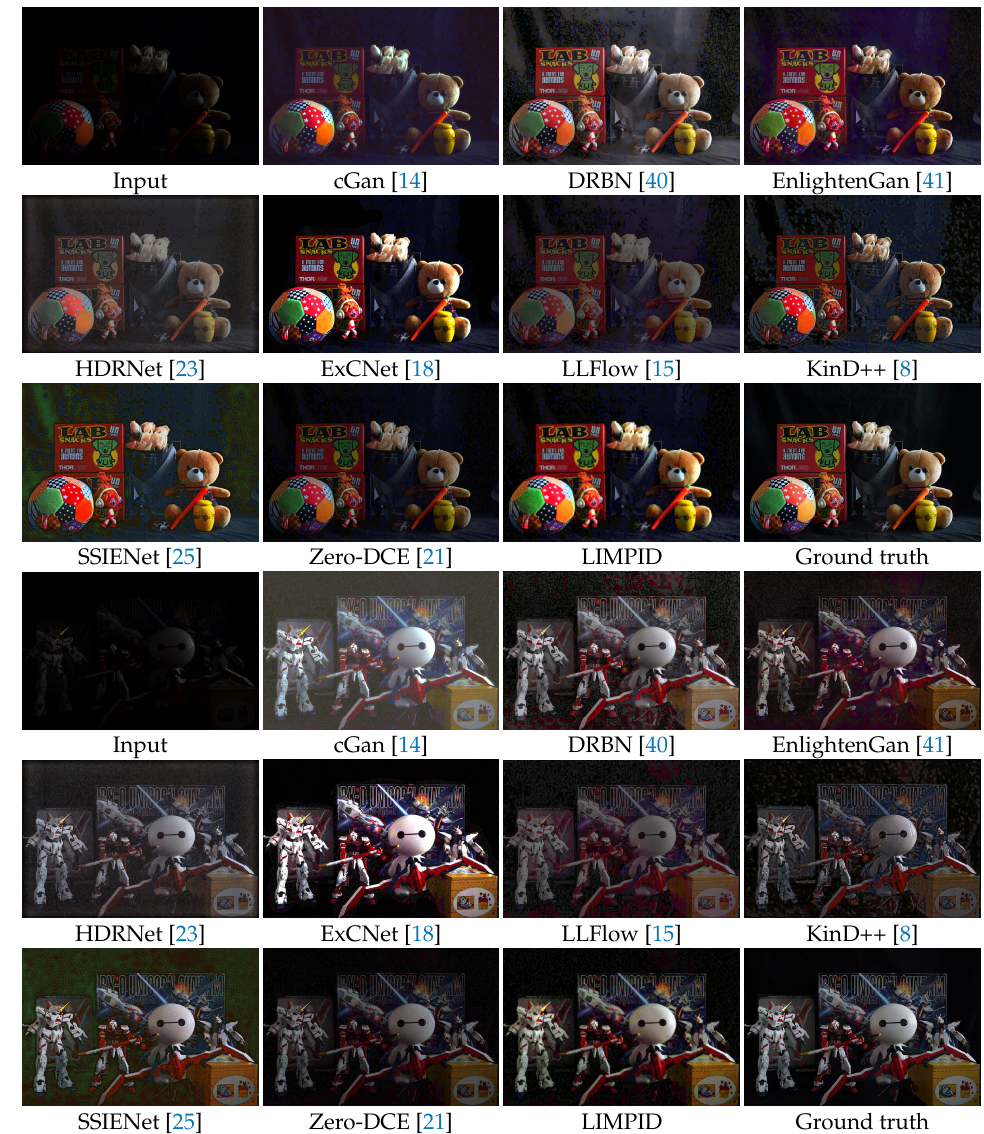
Figure 5. Results on the ELD dataset of LIMPID and existing SOTA methods in